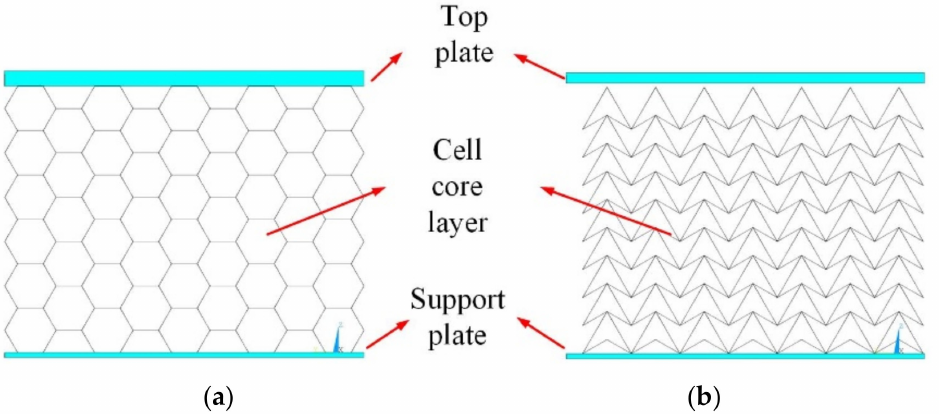
Figure 1. Honeycomb sandwich structures. ( a ) Hexagonal honeycomb sandwich; ( b ) Arrow honey- comb